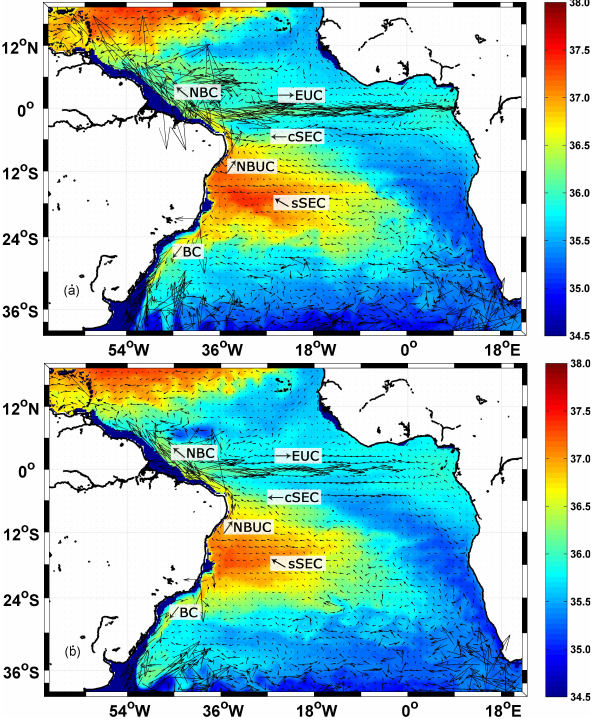
Fig. 7. Horizontal salinity distribution at 110m from Mercator- Coriolis modeling product during: (a) September 1995; and (b) February 1997. Vectors indicate horizontal transport direction: NBC = North Brazil Current; EUC = Equatorial Undercurrent; NBUC = North Brazil Undercurrent; c/sSEC = central/southern branch of the South Equatorial Current; BC = Brazil Current.